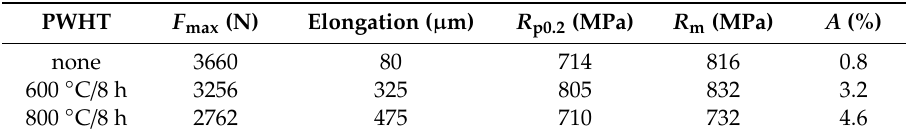
Figure 7. Overview and optical micrographs of the weld metal in different conditions, ( a ) representative stress-strain-diagrams, ( b ) representative optical micrographs of the weld metal with mean values of the alpha laths width. Table 2. Summary results of the tensile tests ( F max : maximum strength load, R p0.2 : 0.2% yield strength;